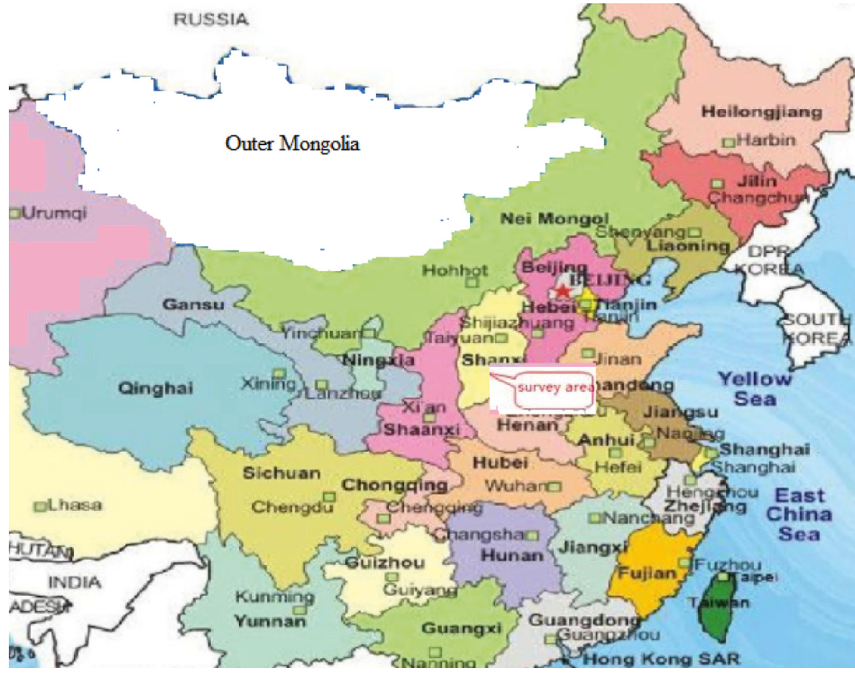
Figure 1: The geographical location of the survey